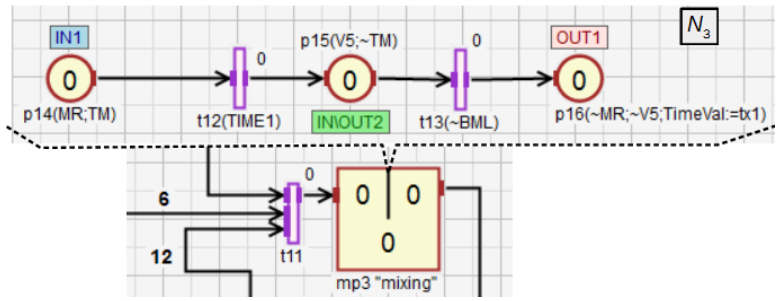
Figure 16. The module for mixing and emptying the